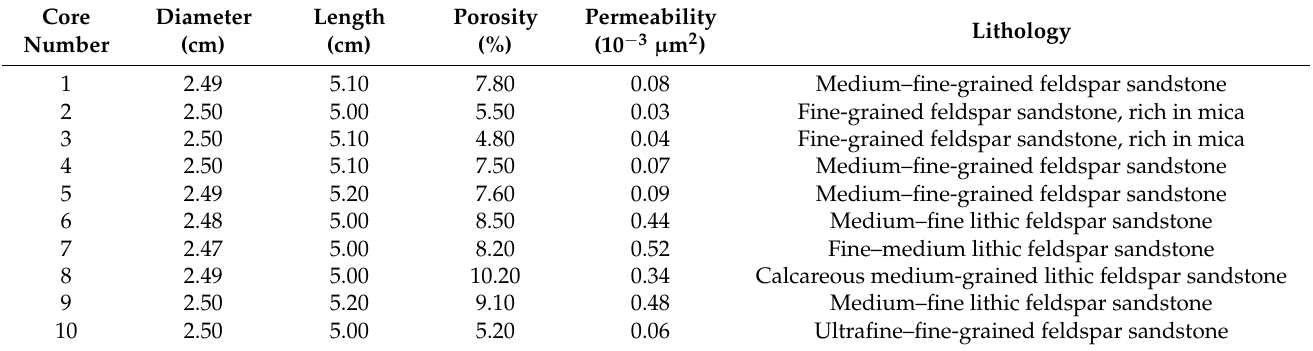
Table 1. Information of Experimental